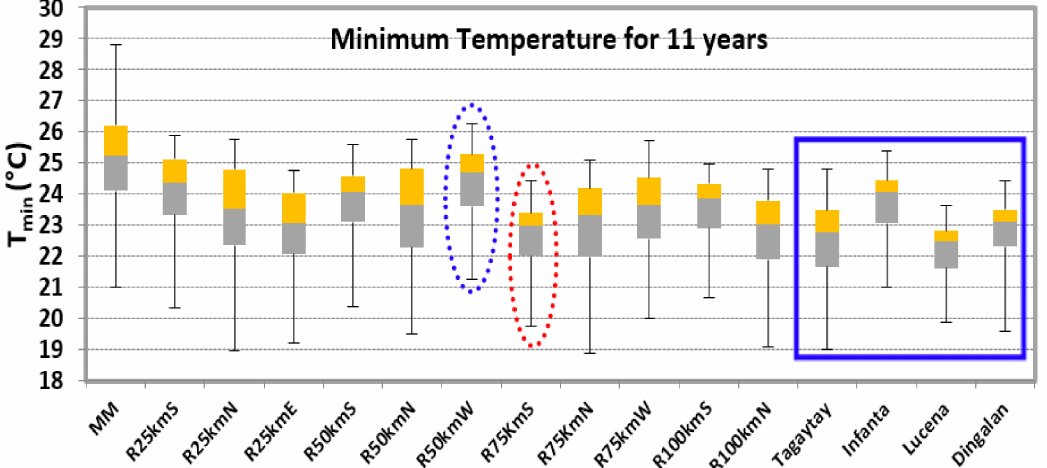
Figure 7. Spatial variation of T min ( ◦ C) for the period 2000–2010. The blue dotted line represents Mariveles while the blue box separates the sites that are elevated and MCC Type II.